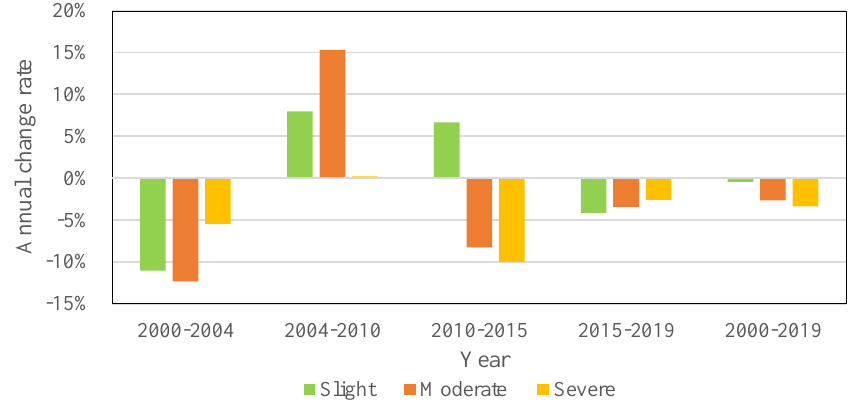
Figure 12. Annual change rate of the ADL area.